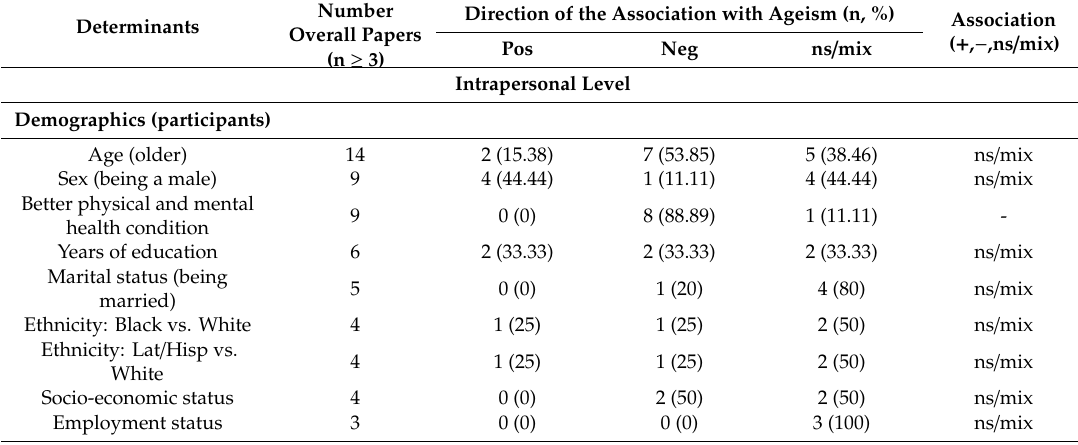
Table 4. Determinants of “self-directed forms of ageism” (total N = 20).